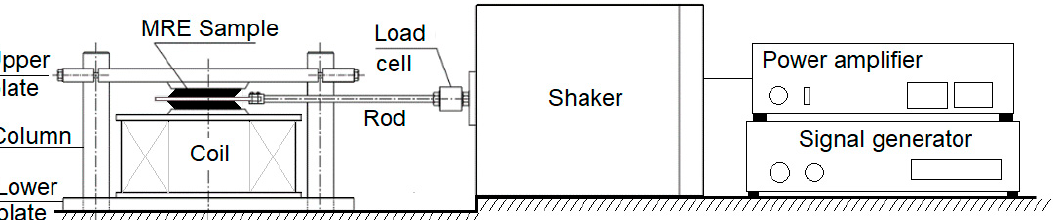
Figure 13. Scheme of the experimental set-up.